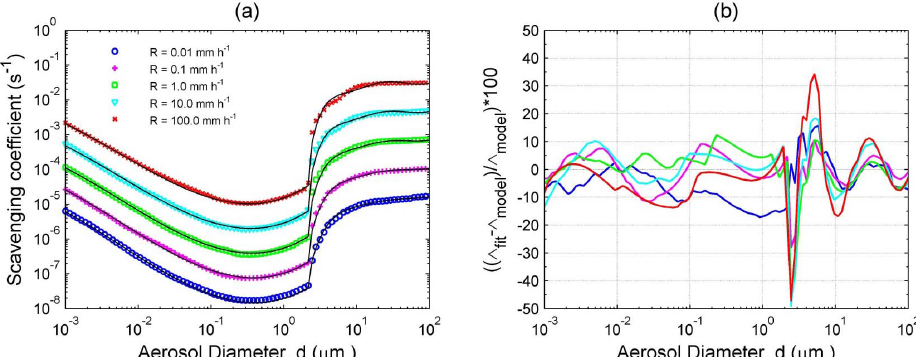
Fig. 3. Parameterized size-resolved 3 rain profiles using Eqs. (5), (6), and (7) (solid lines) and the original 90th-percentile 3 rain data (symbols) (a) and their percentage differences (b) for five different precipitation intensities.